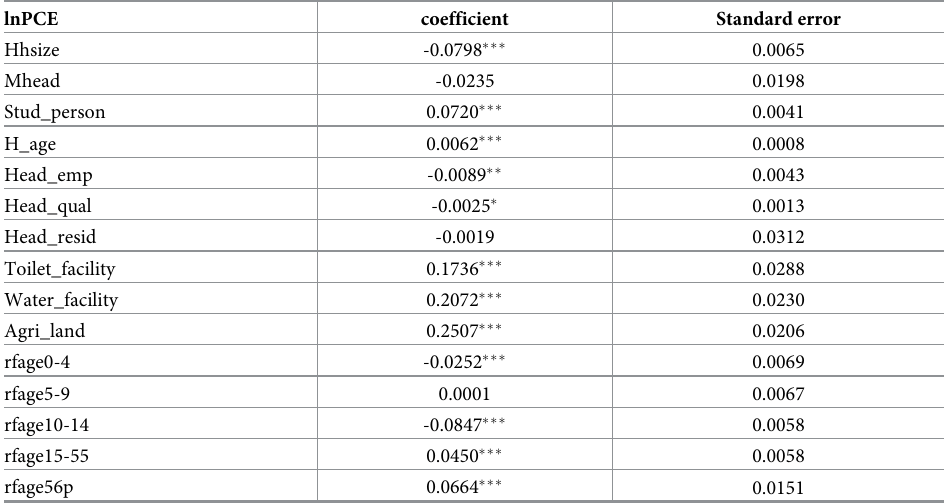
Table 8. OLS Regression estimates with partially simulated error